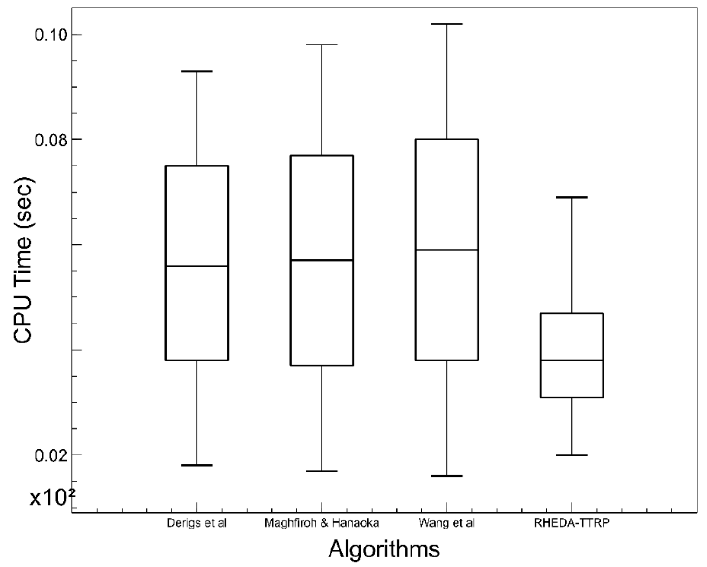
Figure 12. Computational time comparison [37–39].